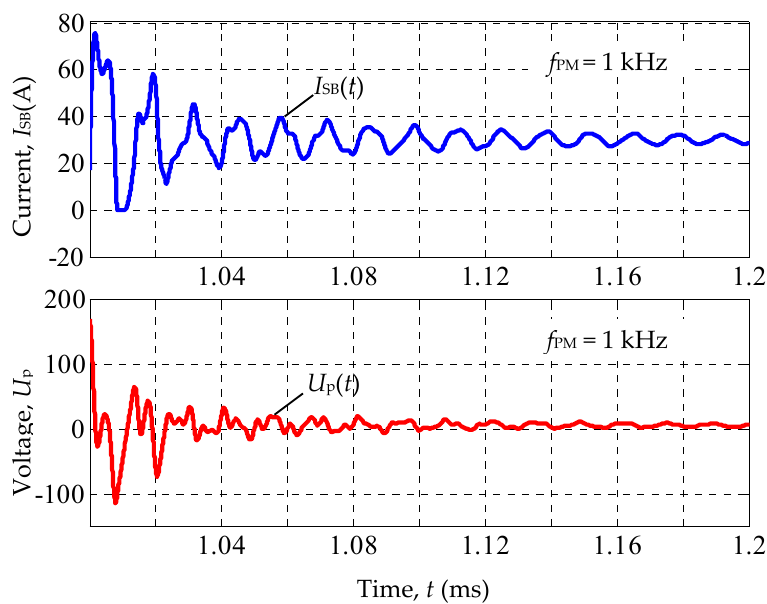
Figure 9. Change in current I SB ( t ) of the panel and voltage U p ( t )on the photocells when the shunt switch is closed.